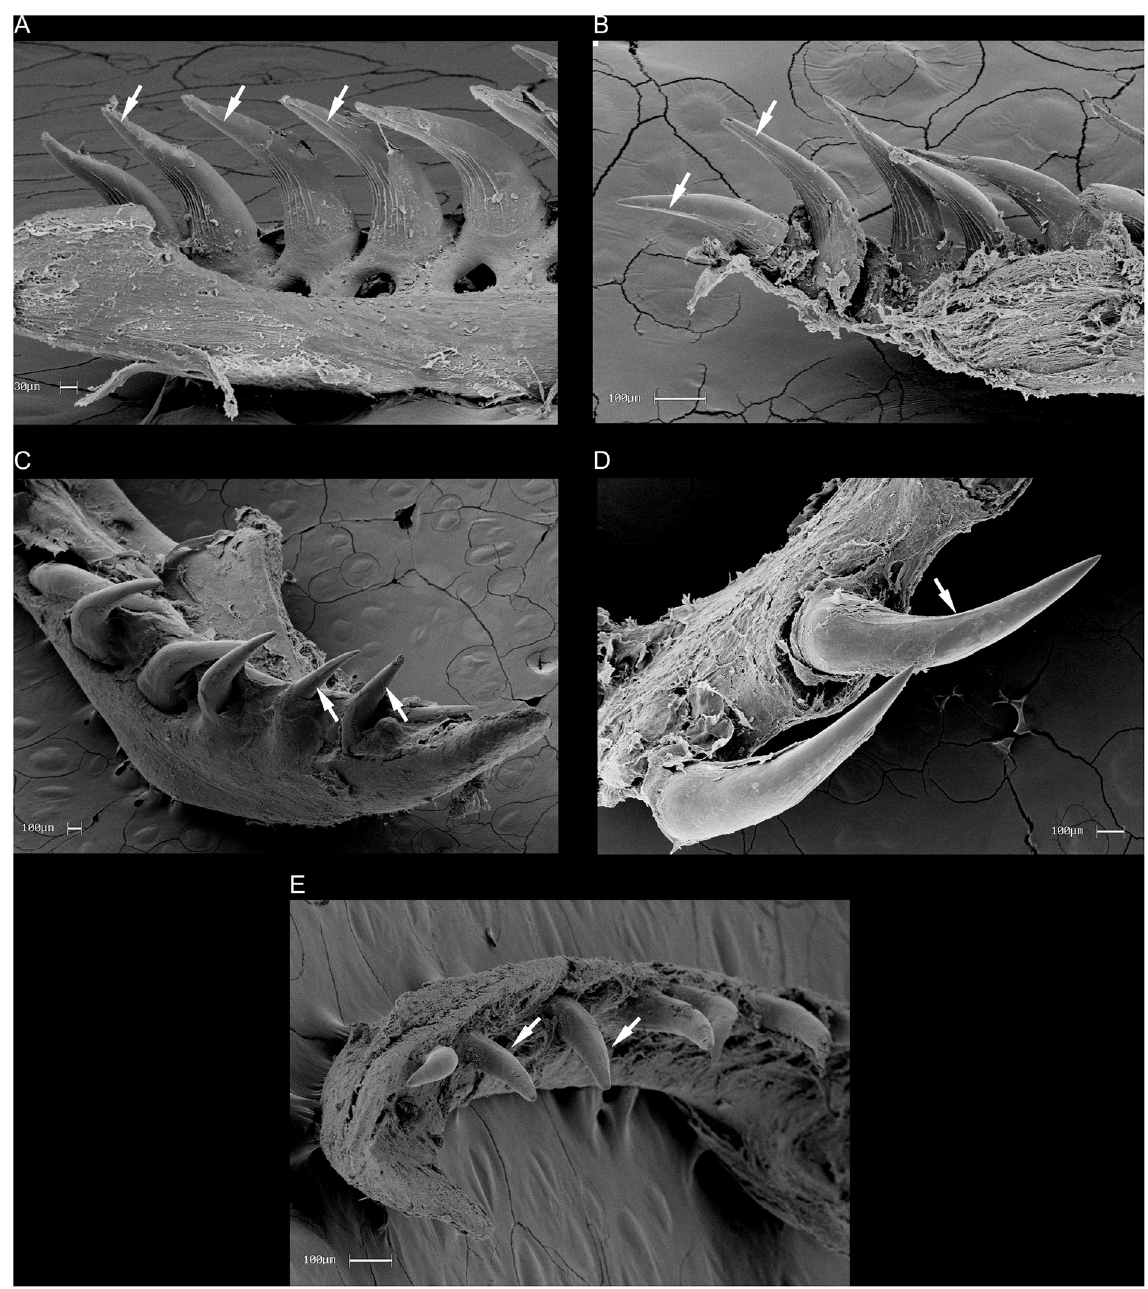
Fig 30. Scanning electron microscopy of maxillary teeth in Acrochordidae, Xenodermidae, Pareidae, and Xylophiinae. (A) right posterior maxillary teeth of Achalinus formosanus in lingual view; (B) right posterior maxillary teeth of Achalinus rufescens in lingual view; (C) right posterior maxillary teeth of Acrochordus granulosus in labial view; (D) left posterior maxillary teeth of Pareas sp. in lingual view; (E) right posterior maxillary teeth of Xylophis perroteti in labial view. White arrows are pointing to the lateral (labial) and medial (lingual) ridges in the posterior maxillary